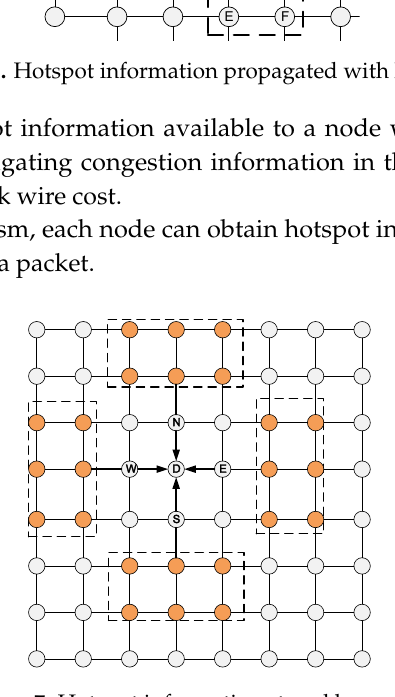
Figure 7. Hotspot information stored by a